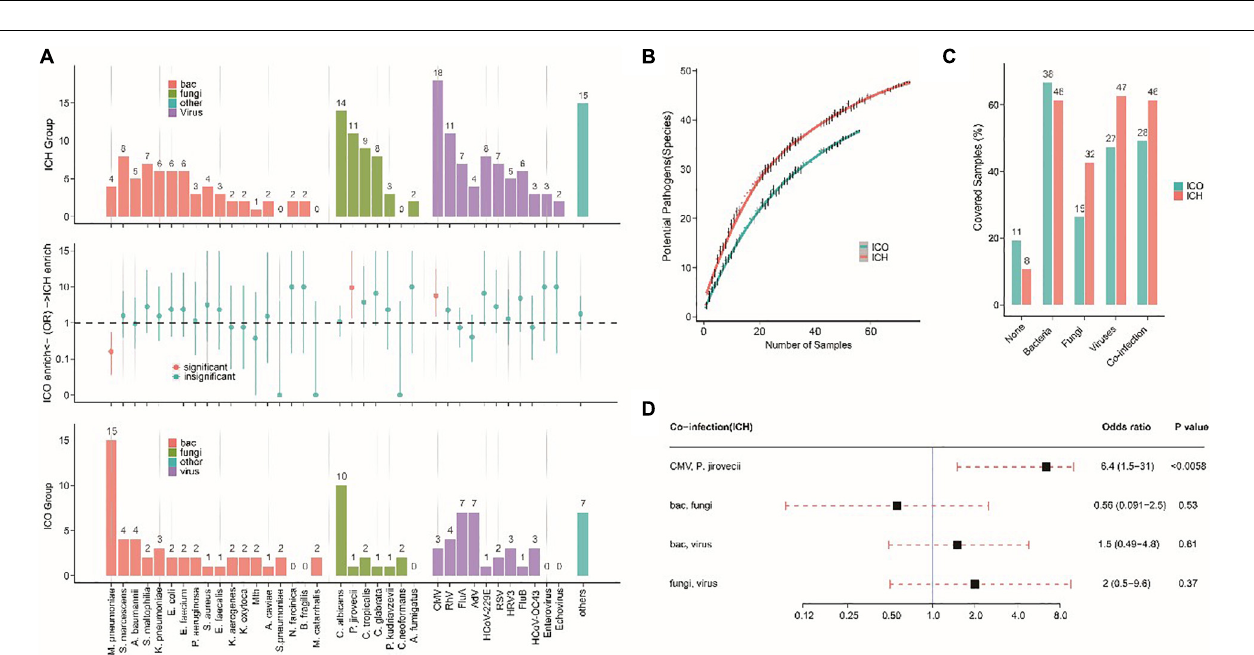
FIGURE 3 | Comparison between conventional testing and PneumoSeq for pathogen detection in BALF and sputum samples. (A) Differences in rates of positivity by case, *** P < 0.001 by the chi-square test. (B) Differences in the numbers of pathogens detected. bac, bacteria; BALF, bronchoalveolar lavage fluid.